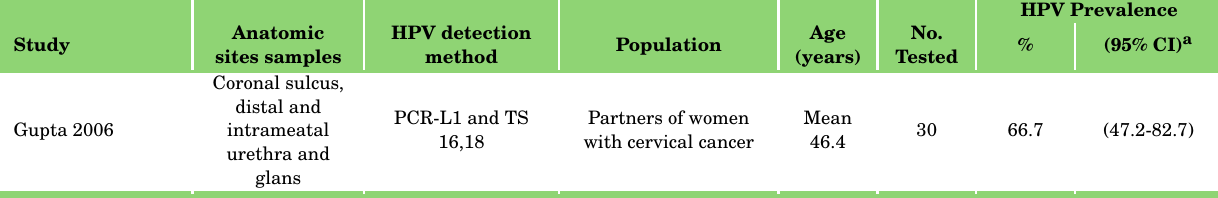
Table 34: Studies on HPV prevalence among men from special subgroups in